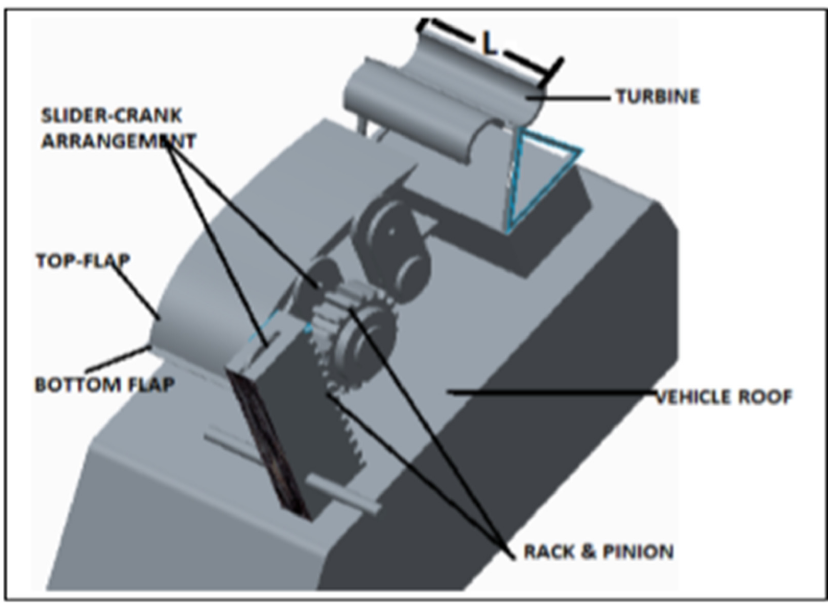
Figure 2. Airfoil mechanism and Savonius wind turbine placed on train roof [21].